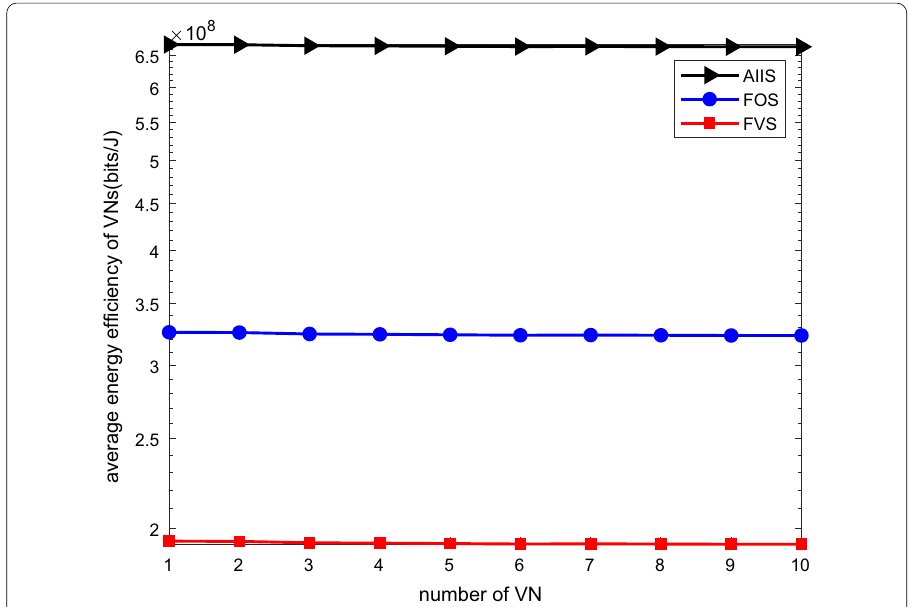
Fig. 5 The average energy efficiency of vehicle nodes (VNs) versus the different numer of VNs